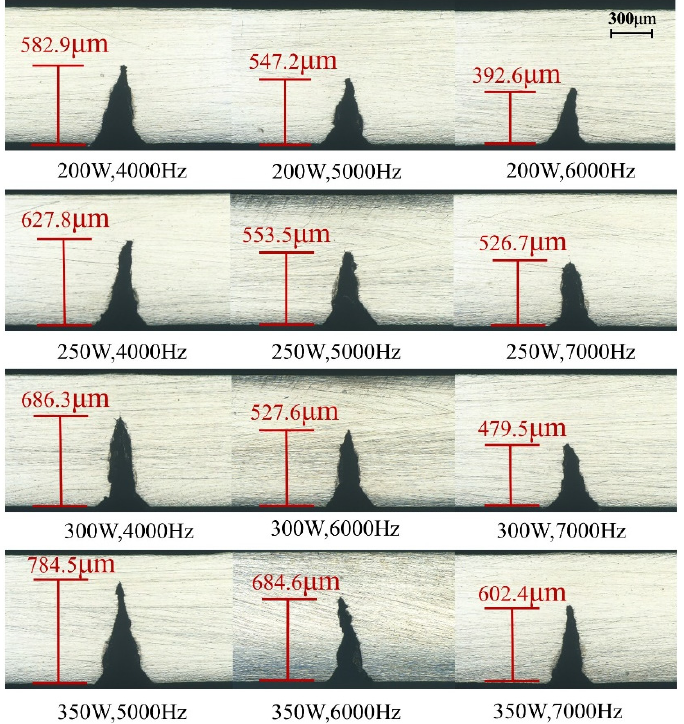
Figure 11. Cutting depth at different laser powers and pulse frequencies (excluding 1.8 MPa water pressure).